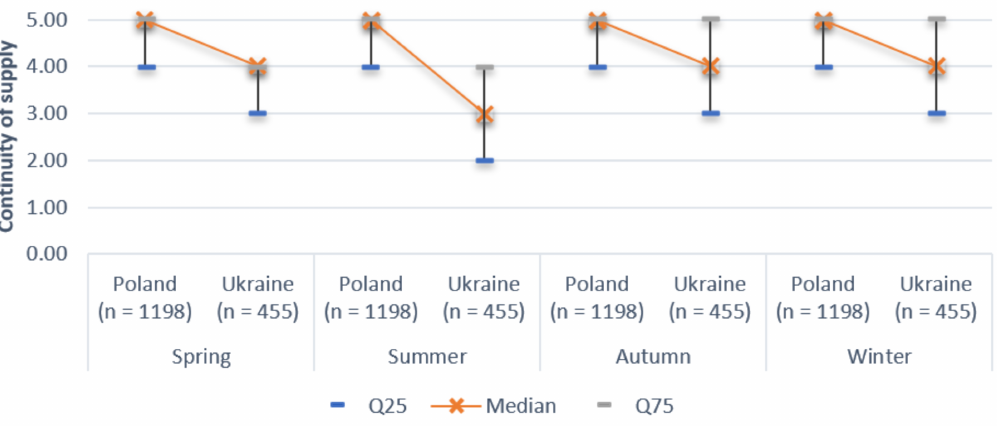
Figure 9. Evaluation of continuity of tap water supply during individual seasons of the year according to the groups of respondents from Poland and